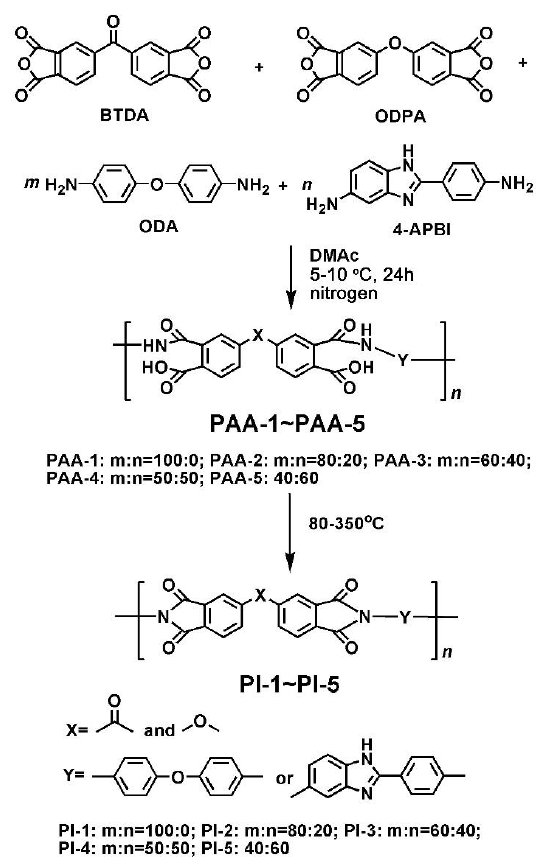
Figure 1. Preparation of PI coatings.